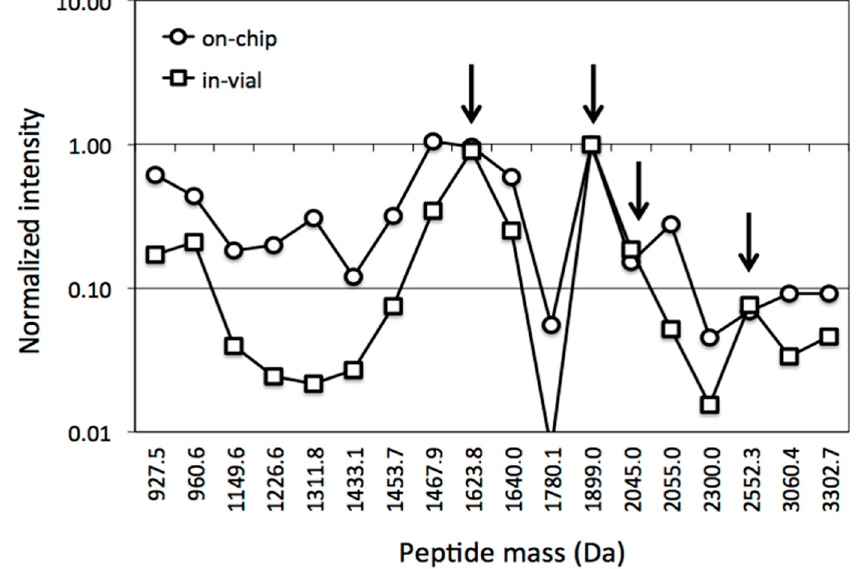
Figure 4. Intensities of the 18 main peaks belonging to both spectra in Figure 3 after normalization with respect to the intensity of the maximum one (at m / z of 1899 Da). Lines connecting data points have no experimental meaning: they only aim to guide the eye. Apart from a group of four peaks, whose normalized intensities are the same in the two digestions (arrows), i.e., they are not affected by the interaction with the vial walls, all others systematically show a lower normalized intensity in the spectrum related to in-vial digestion. Logarithmic vertical axis helps to show smaller normalized intensities and highlights the huge overall decrease in peptide intensities from in-vial processing.